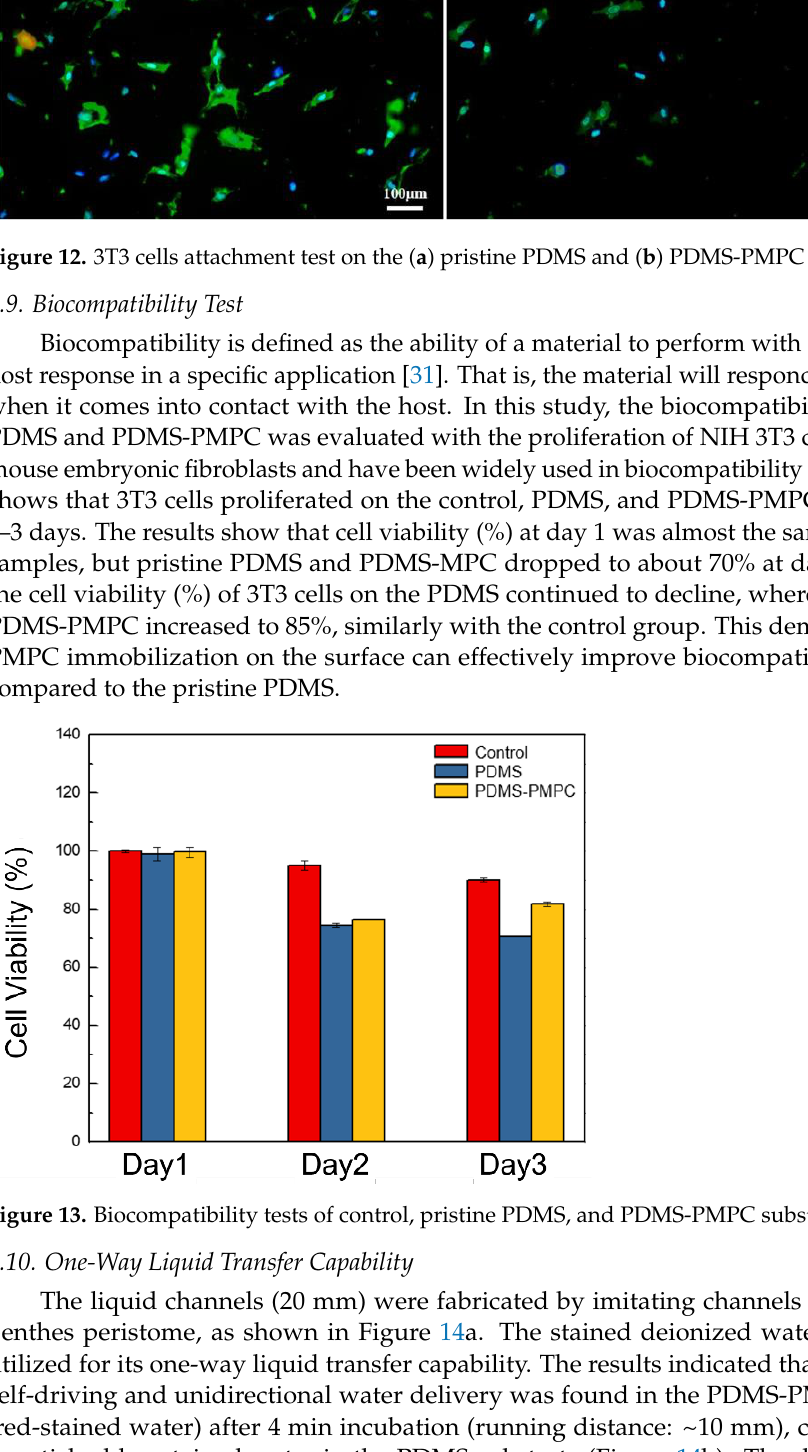
Figure 13. Biocompatibility tests of control, pristine PDMS, and PDMS-PMPC substrates ( n = 3).